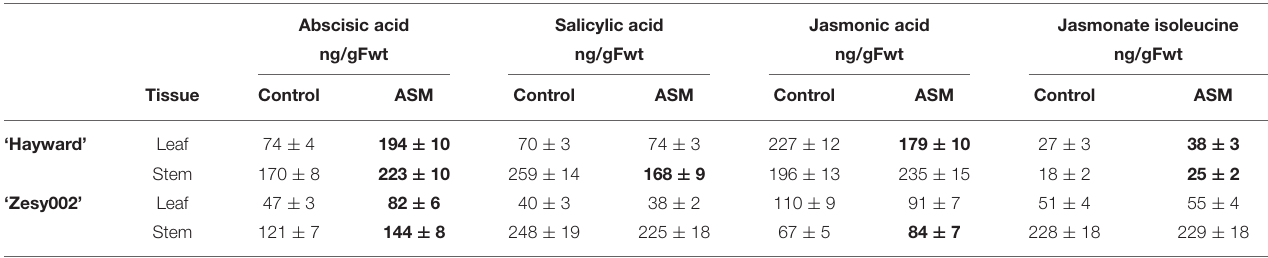
TABLE 4 | Effect of Actigard (ASM) on the concentrations (ng/g Fwt) of salicylic acid (SA), abscisic acid (ABA), jasmonic acid (JA), and jasmonate isoleucine (JA-ile) at the stem inoculation site and in the adjacent leaf in Actinidia chinensis var . deliciosa ‘Hayward’ and A. chinensis var . chinensis ‘Zesy002’ potted